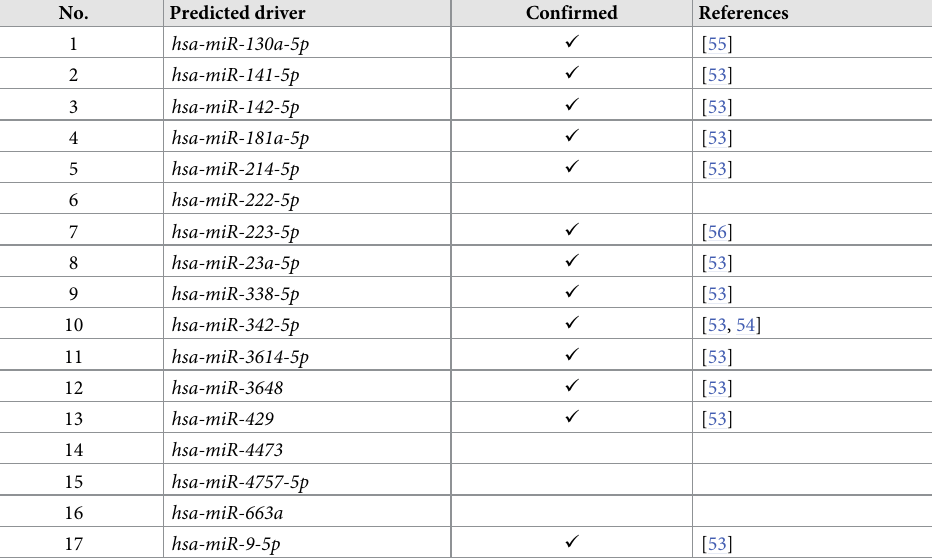
Table 2. miRNA BRCA drivers predicted by